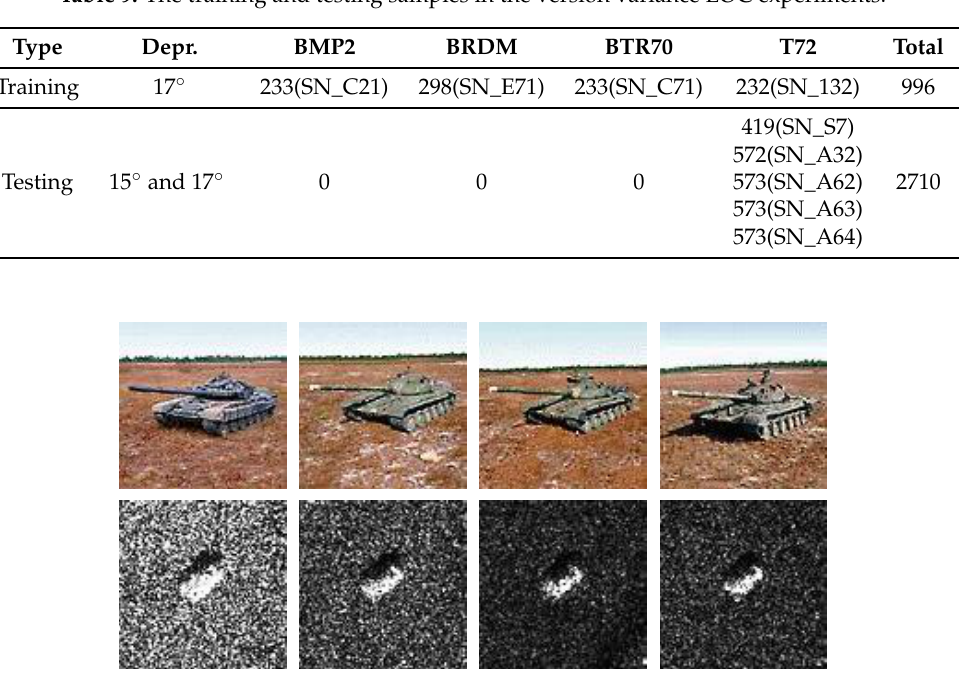
Table 9. The training and testing samples in the version variance EOC experiments.